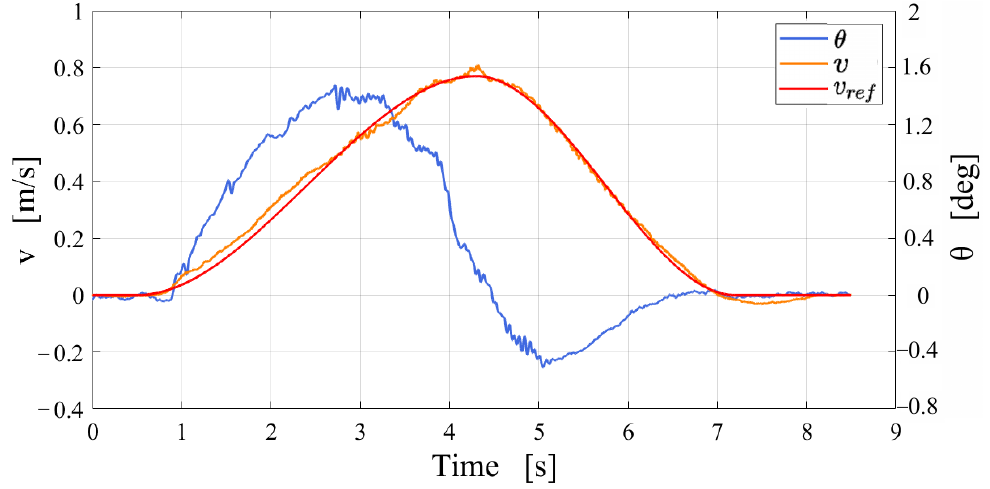
Figure 12. Date graph of the upright balanced moving experiment on the outdoor road: v is the forward velocity of the robot; θ is the angle between the CoM and the z